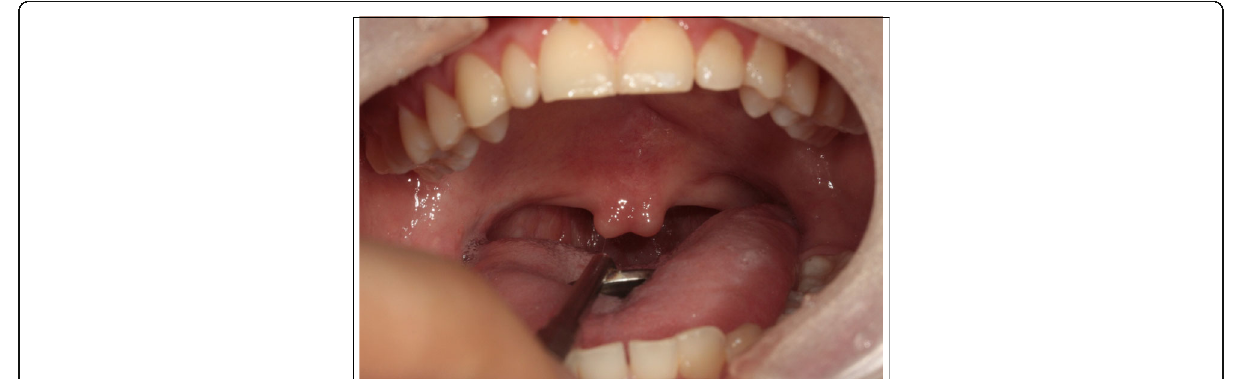
Fig. 2 Intraoral view during pronouncing /a/. The VP function is not working well during pronunciation showing VPI. This patient showed severe nasal